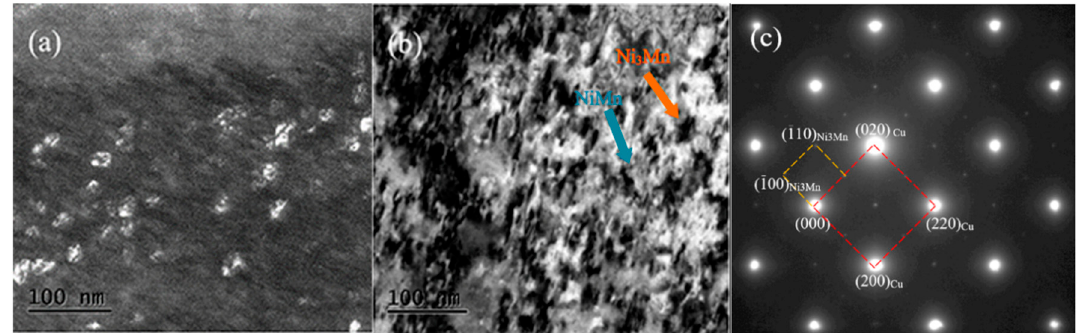
Figure 6. TEM micrographs of the rolled specimens aged at 450 °C for 48 h: ( a ) the dark field image of the Ni 3 Mn phase, ( b ) the bright field image, ( c ) [001] Cu SAED pattern of the specimen.